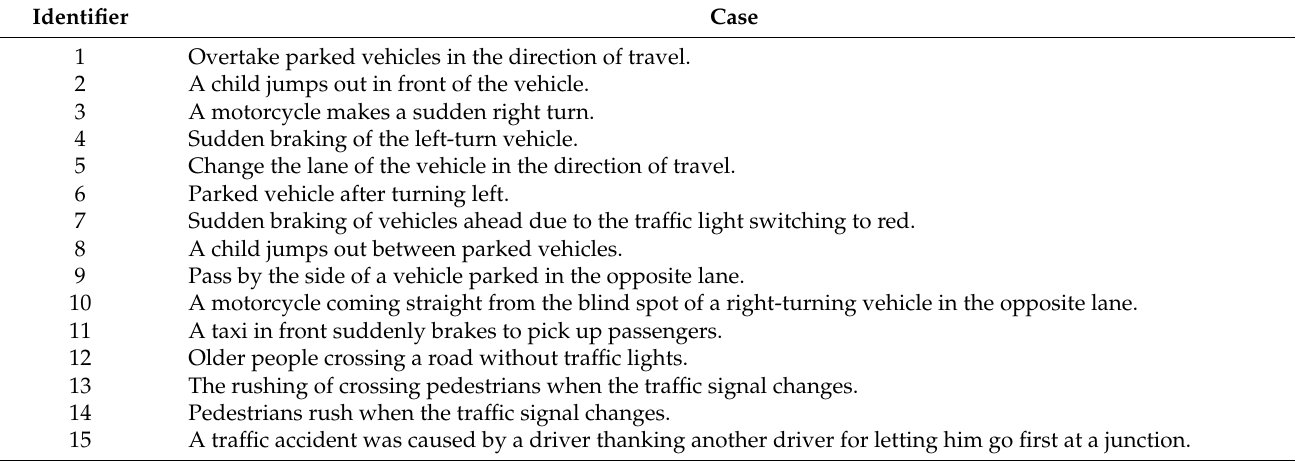
Table 2. Cases where collision accidents are included in the driving route and likely to occur.